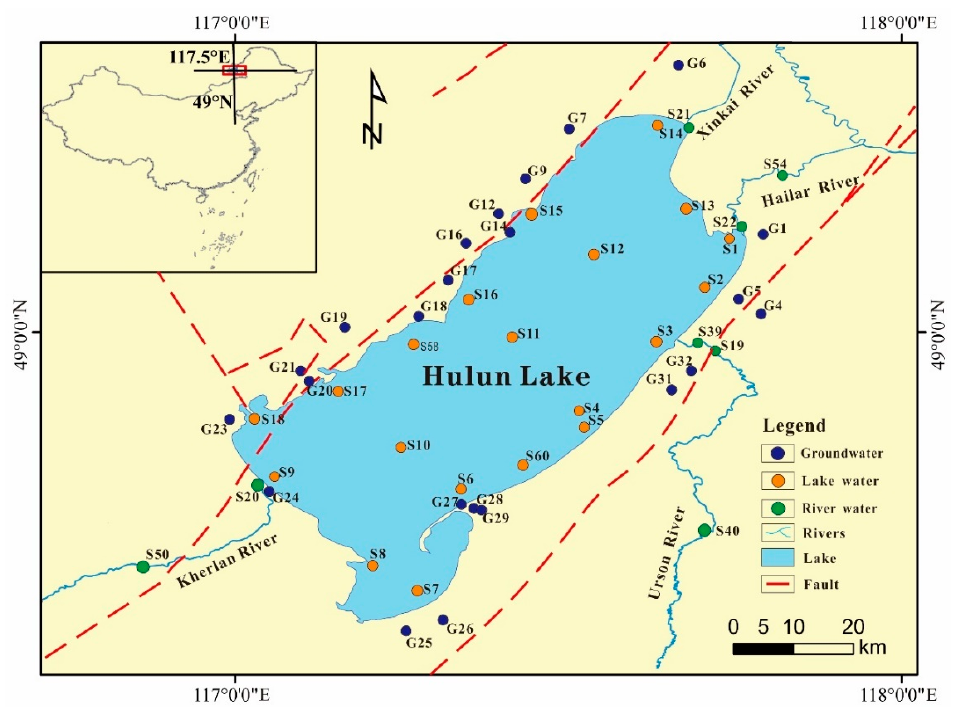
Figure 1. Plot of the Hulun Lake area and distribution of the sampling points.